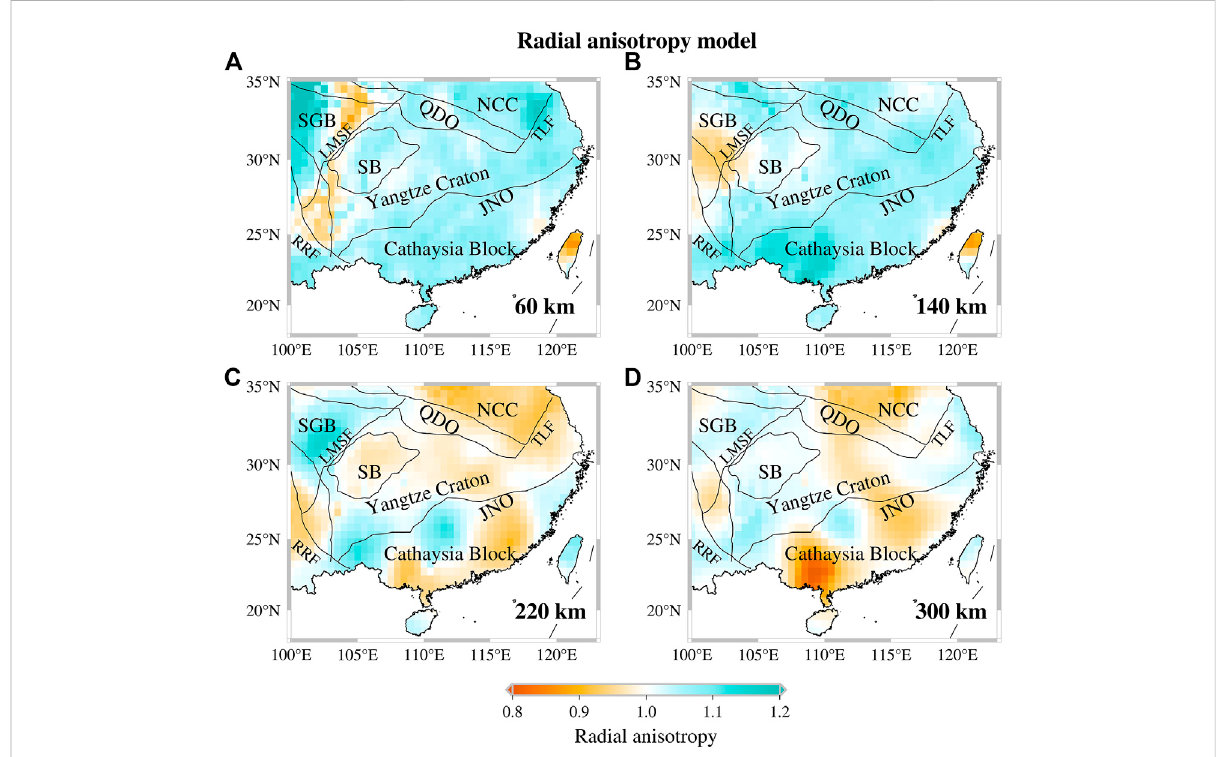
FIGURE 8 Radial anisotropy distribution of the mantle component of SREM-SC at (A) 60 km (B) 140 km (C) 220 km, and (D) 300 km depths, determined from the SV wave velocity of SREM-SC and SH wave velocity of Tang et al. (2022).